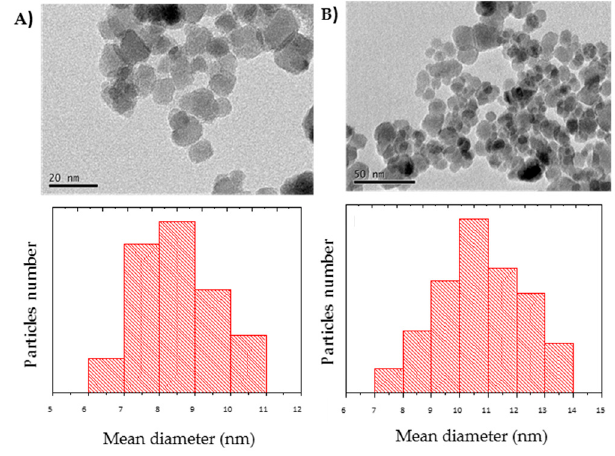
Figure 6. TEM micrographs and size distribution of: ( A ) nude magnetic nanoparticles (MNPs) and ( B ) amino-functionalized nanoparticles (AMNPs).